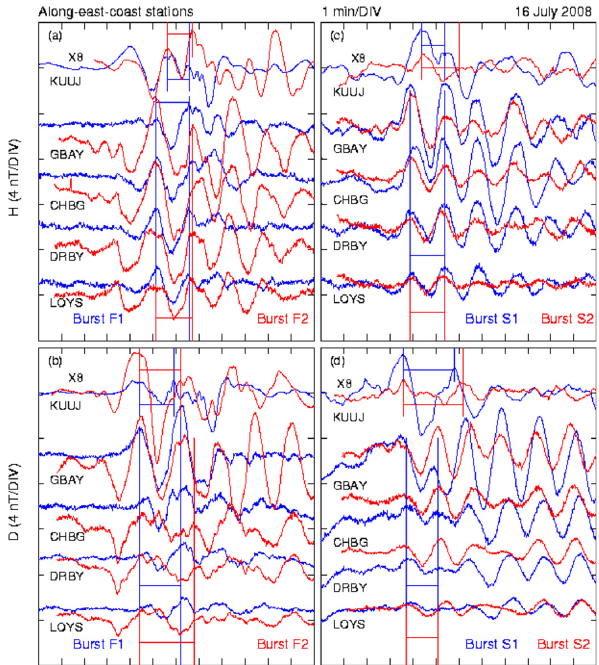
Fig. 6. (a) The H-component at the THEMIS ground stations along the East Coast of North America for the F1 and F2 bursts on 16 July 2008. The blue trace denotes the F1 burst and the red trace the F2 burst. The blue horizontal line denotes the distinct wave period of the F1 burst and the red horizontal line the F2 burst. (b) In the same format as (a) , except for the D-component. (c) In the same format as (a) , except for the S1 and S2 bursts. (d) In the same format as (c) , except for the